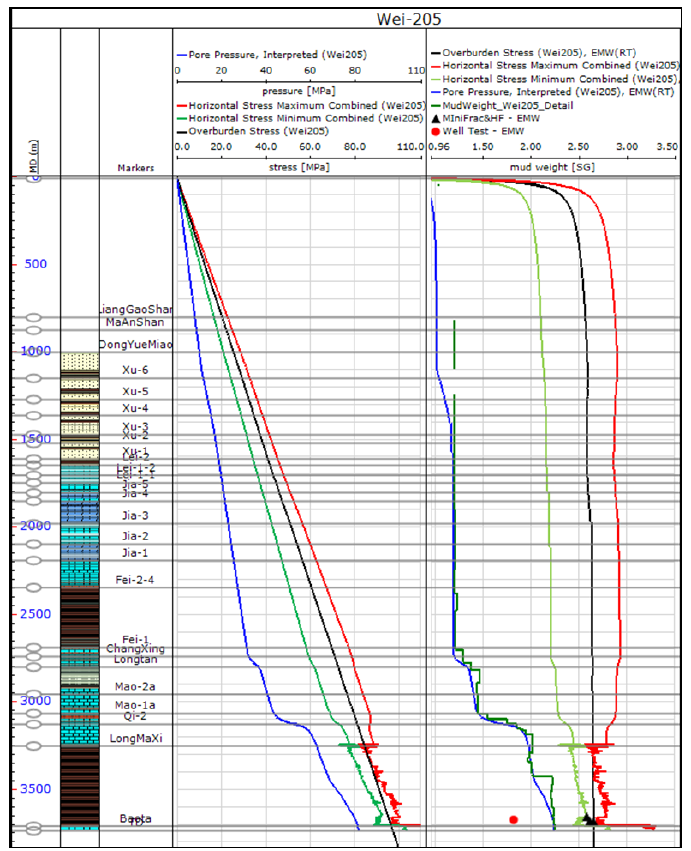
Figure 20. Final stress and pore pressure model for W205.